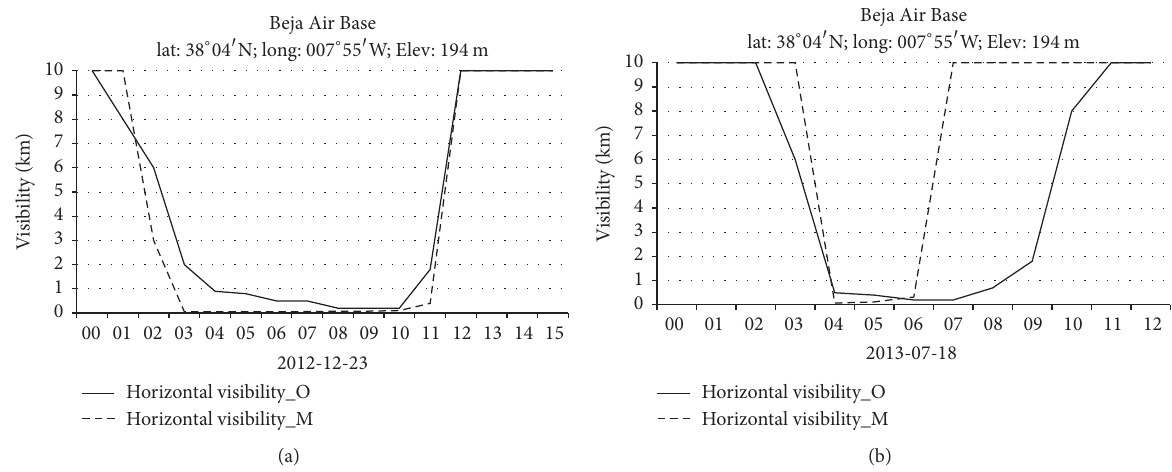
Figure 7: Comparison between the horizontal visibility observed and simulated data (D02) at Beja Air Base in (a) 23/12/2012 and (b) 18/07/2013. UTC hours.